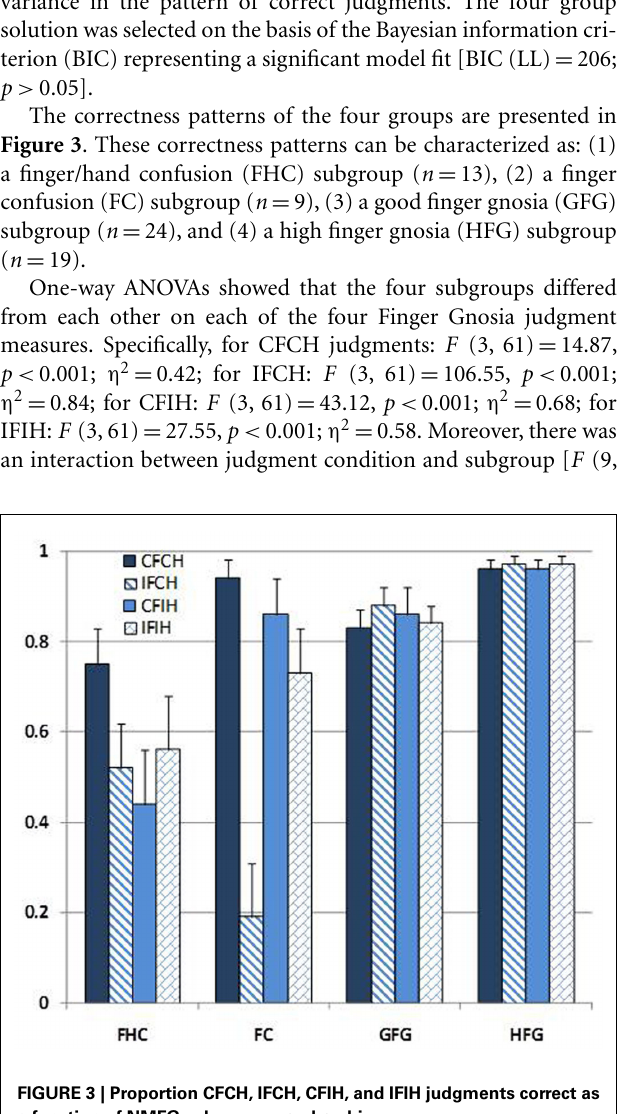
FIGURE 3 | Proportion CFCH, IFCH, CFIH, and IFIH judgments correct as a function of NMFG subgroup membership.